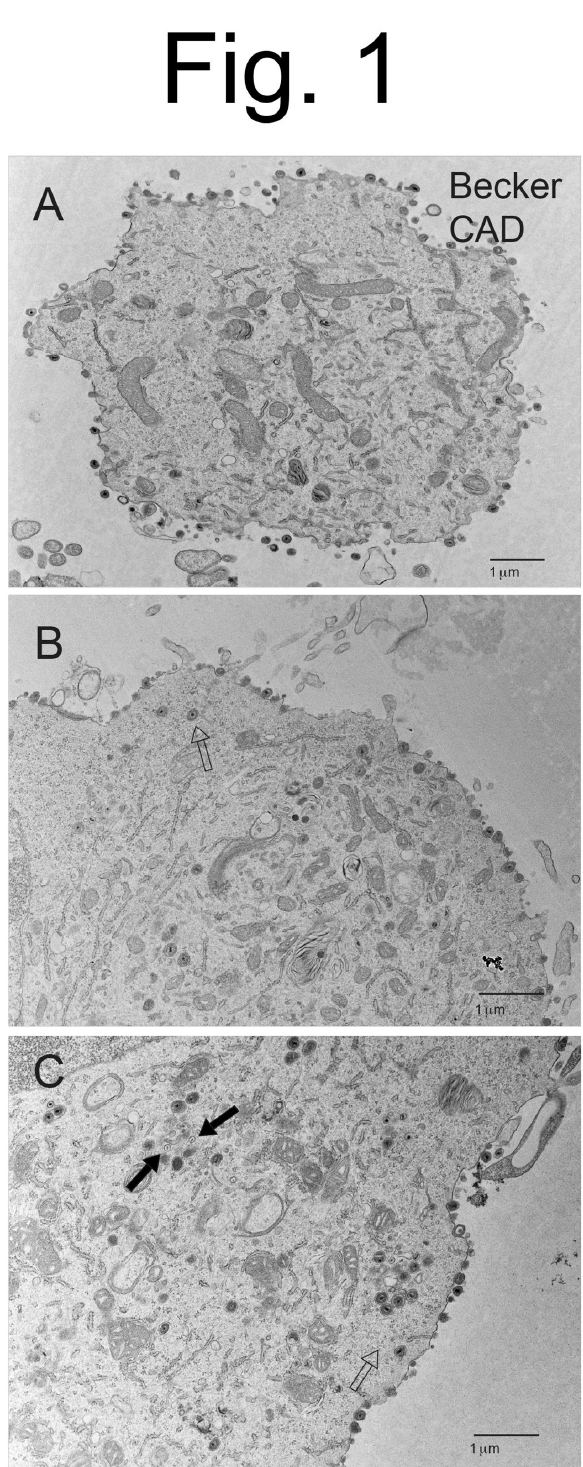
Figure 1. Electron micrographs of CAD neurons infected with wild-type PRV Becker. Differen- tiated CAD neurons growing on poly-lysine/laminin coated glass coverslips were infected with wild-type PRV Becker for 10–12 h. The cells were then fixed and processed for electron microscopy (EM). Panel ( A ) shows a section of the extremity of a neuron, without an obvious nucleus, that exhib- ited numerous cell surface particles and fewer cytoplasmic particles. Panel ( B , C ) shows numerous cell surface particles, as well as fewer cytoplasmic enveloped particles (empty arrow) and unenveloped capsids (solid